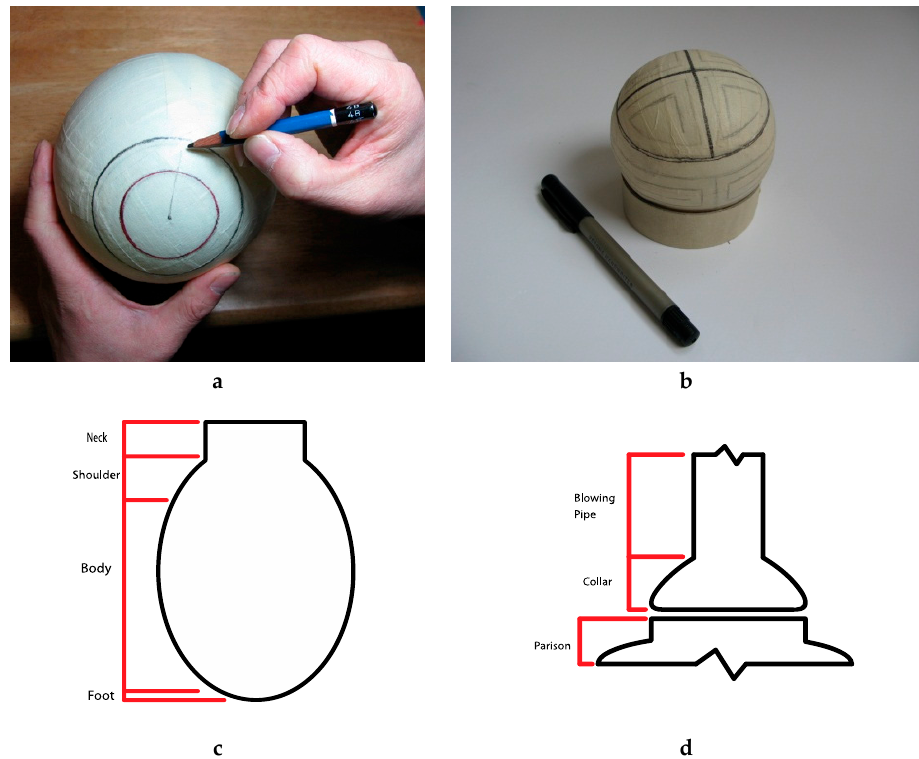
Figure 4. ( a , b ) Applying the design with a pencil and fibre-tipped pen. ( c ) Diagram 1: technical terms for the parison parts; ( d ) Diagram 2, technical terms for the parison parts and a prepared gather on a blowing pipe.